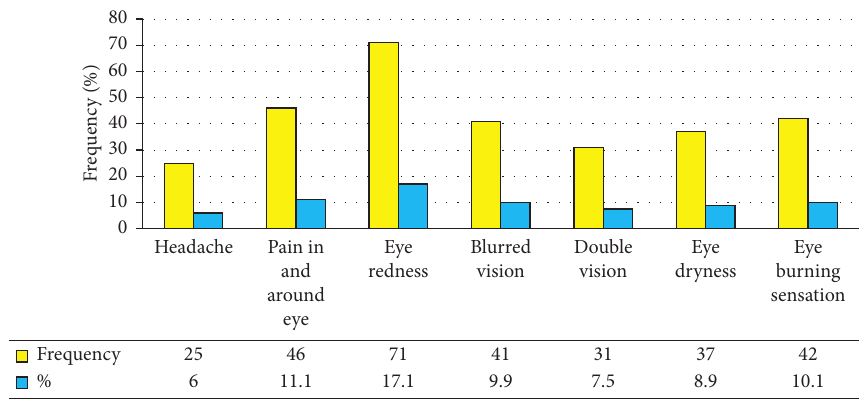
Figure 1: The symptoms of computer vision syndrome mentioned by university instructors in Ethiopia, 2021.